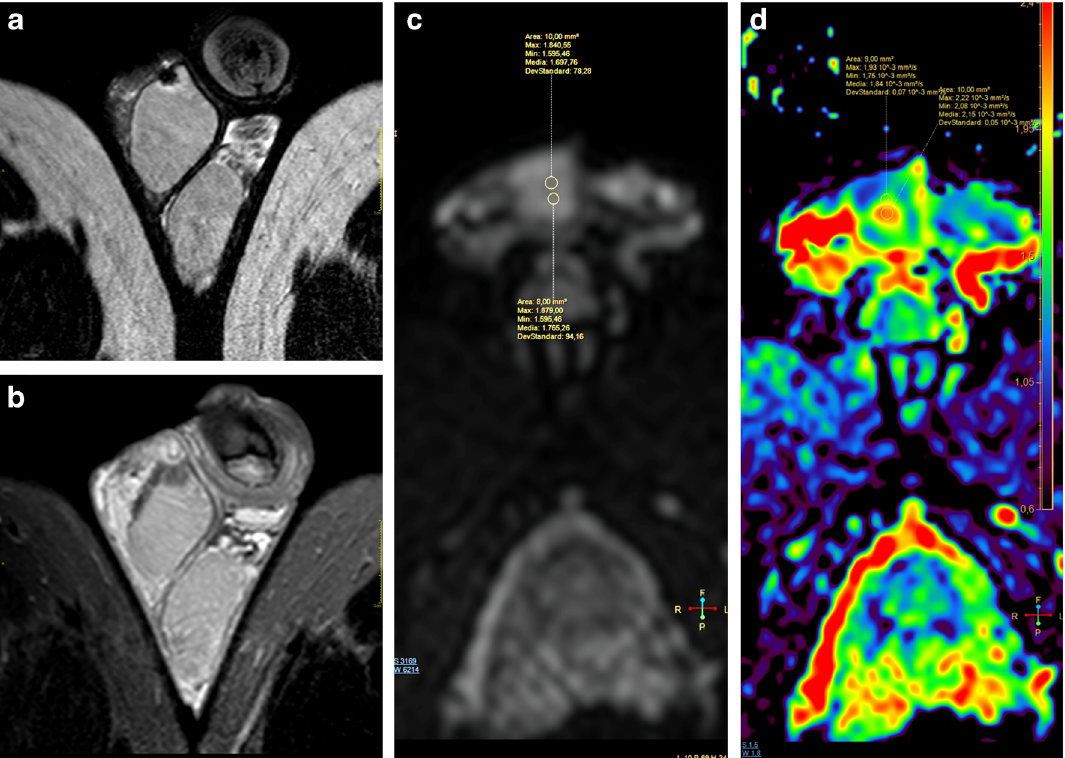
Fig.8 a - d Hypoechogenic lesionatthe siteofprevioustumour enucleation(Leydig cells tumour). MRIallowedthe identification ofan areaoffibrosis. a T2-weighted TSE sequence, coronal view; b postcontrast T1-weighted SPIR TSE sequence; c-d. ADC